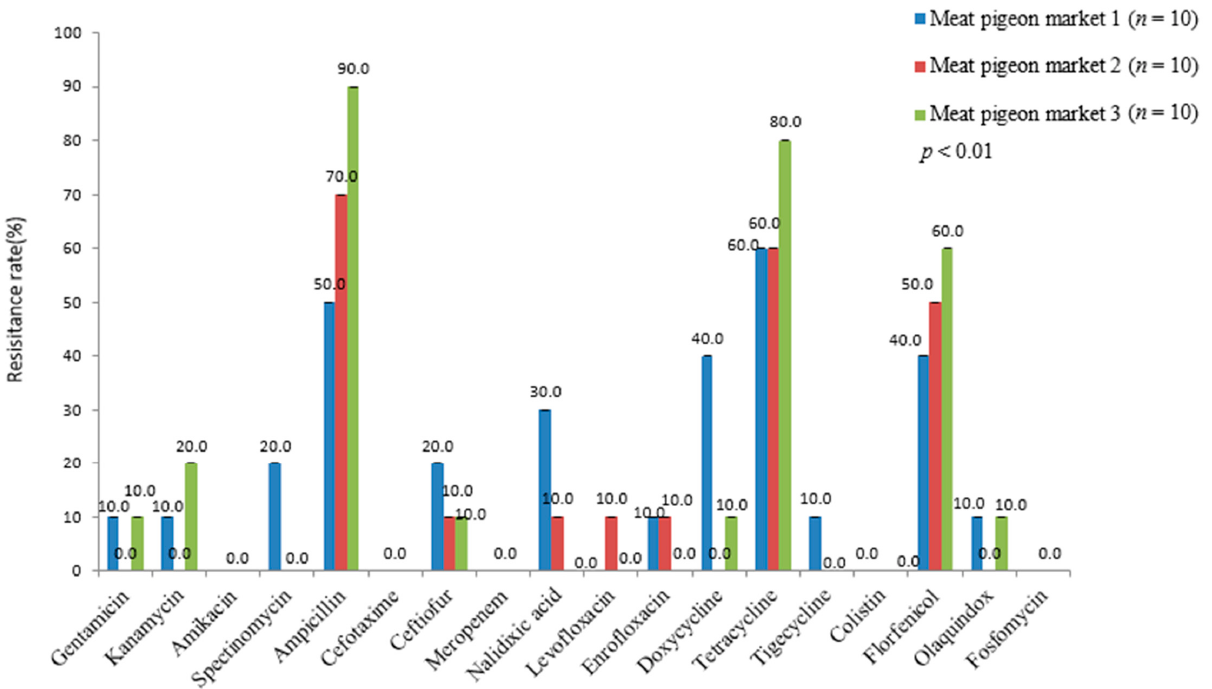
Figure 3. AMR comparison of E. coli isolates from meat pigeons in different breeding markets.